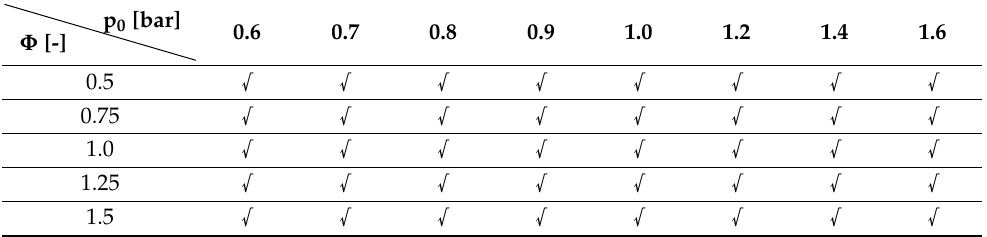
Table 1. Ranges of initial pressure and equivalence ratio used in the experiments.